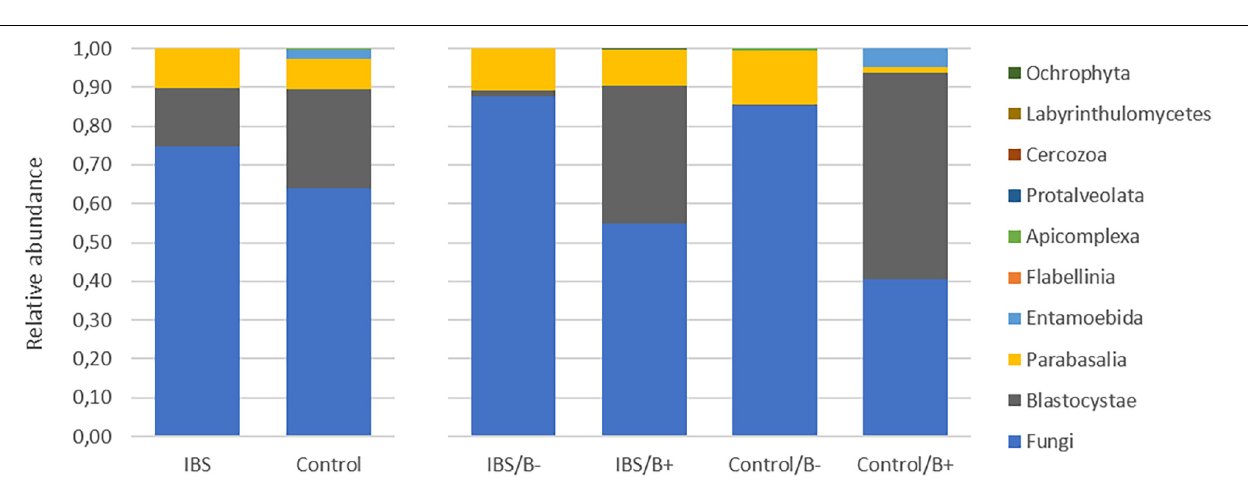
FIGURE 4 | Heat map illustrating changes in functional capabilities in the four groups of patients. The color scale ranges from light yellow to dark red: light yellow indicates a low functional enrichment, and dark red indicates a high functional enrichment of the averaged individual KEGG function.